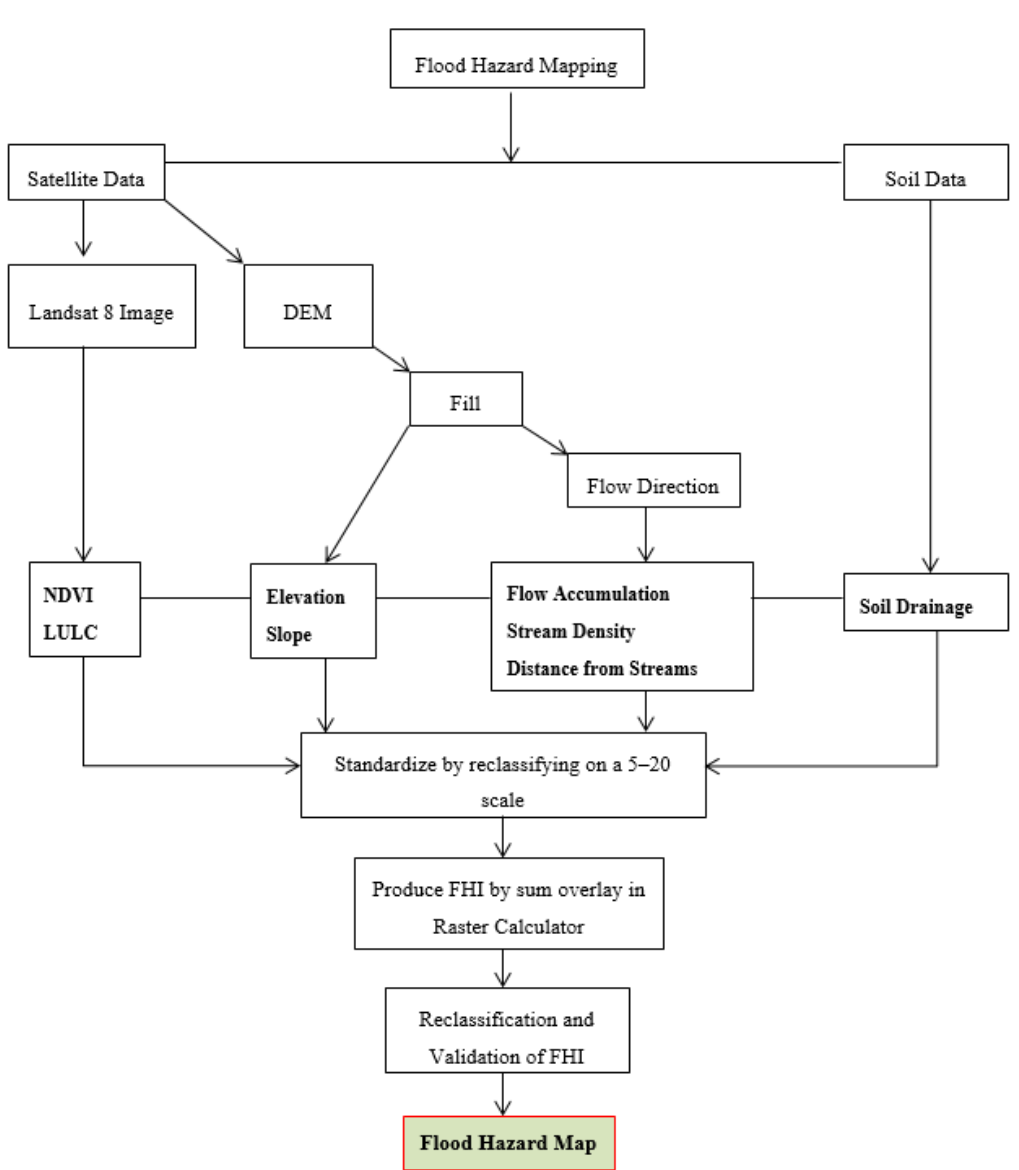
Figure 2. Flowchart for preparing flood hazard map ( NDVI —Normalized Difference Vegetation Index; LULC —Land use/Land cover; FHI —Flood hazard index).